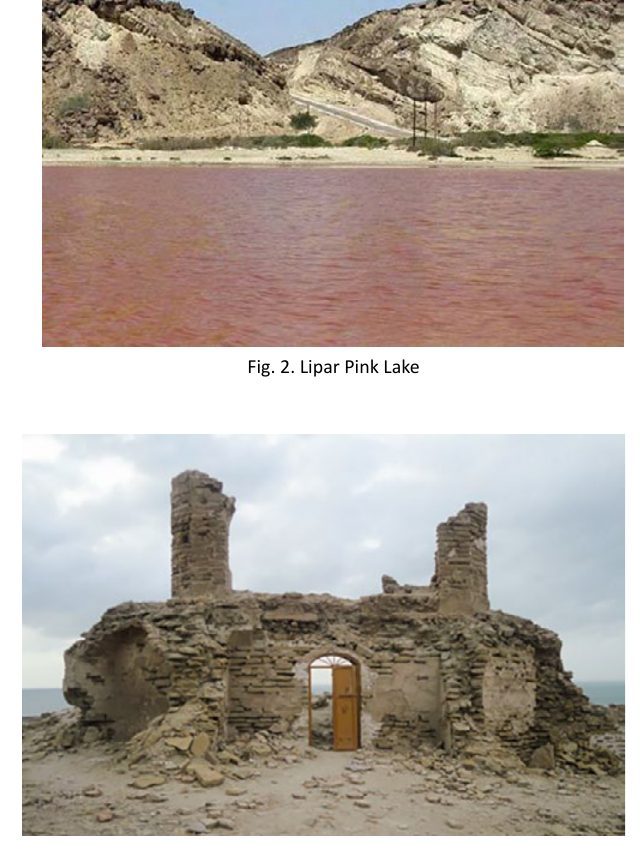
Fig. 3. Tis Fortress (also called Portuguese Fig. 3: Tis Fortress (also called Portuguese Castle)